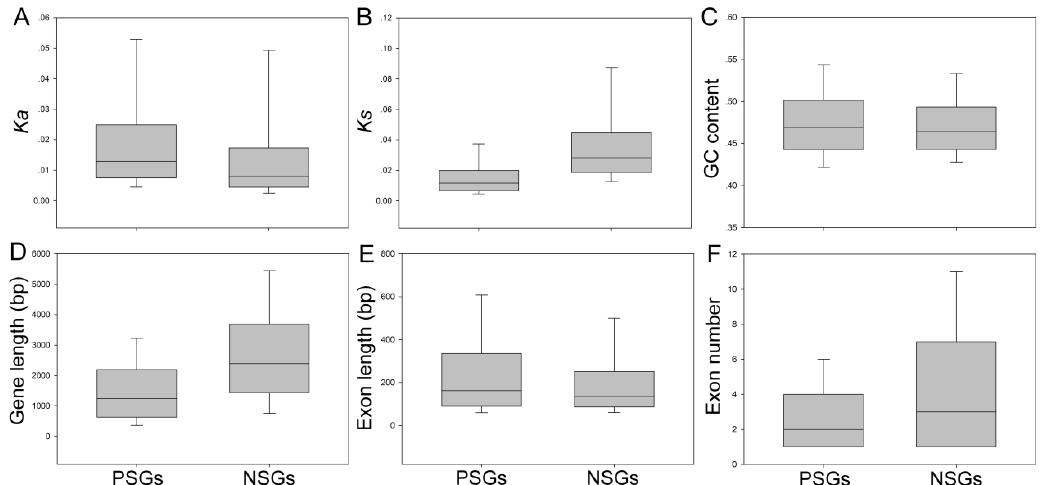
Figure 2. Comparisons of genomic features among different types of negatively selected genes (NSGs) and positively selected genes (PSGs) in Pyrus . The top and the bottom of each box were the third (higher) and first (lower) quartiles. The line represented the median value in the box. Out of range, mild outliers are excluded in this figure. ( A – F ) The box plot displays of Ka, Ks, GC content, gene length, exon length, and exon number between two selections.